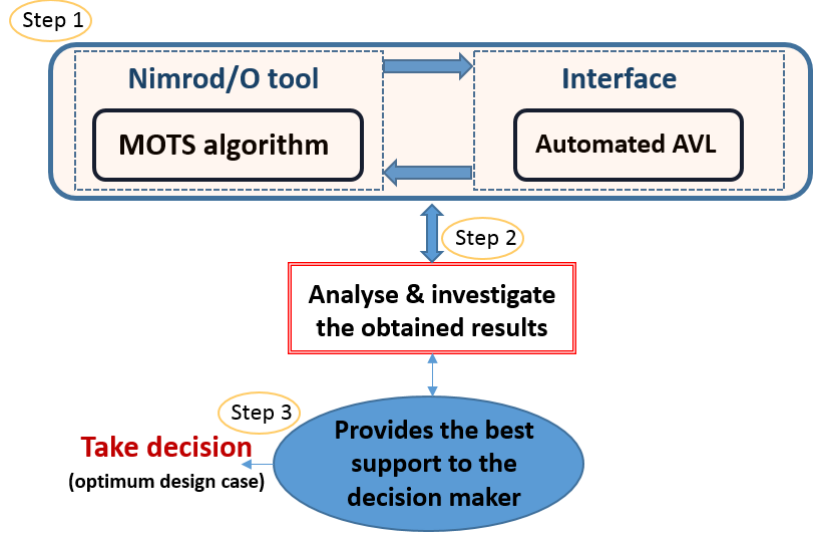
Figure 4. Automated optimisation approach framework (posteriori approach).